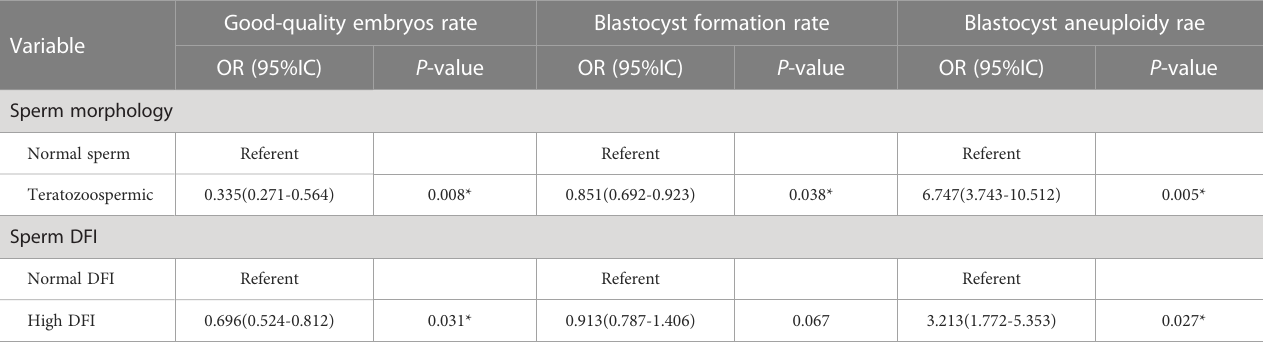
TABLE 3 Logistic regression analysis of variables associated with good-quality embryos, blastocyst formation and blastocyst aneuploidy rate.